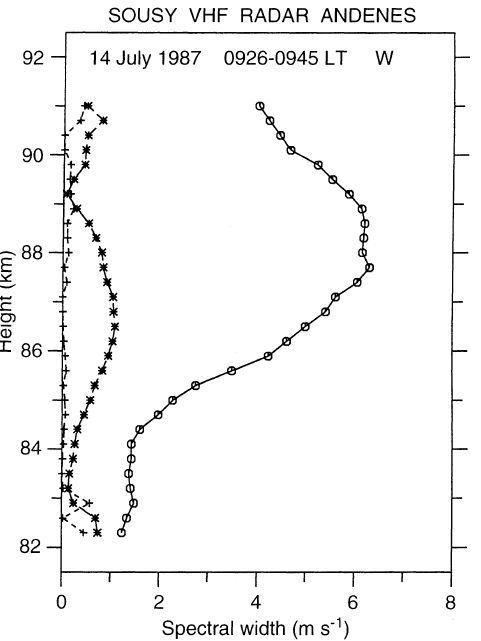
Fig. 4. Height profiles of beam ( asterisks ) and shear ( plusses ) broadening and of the turbulent component of the spectral width ( circles )